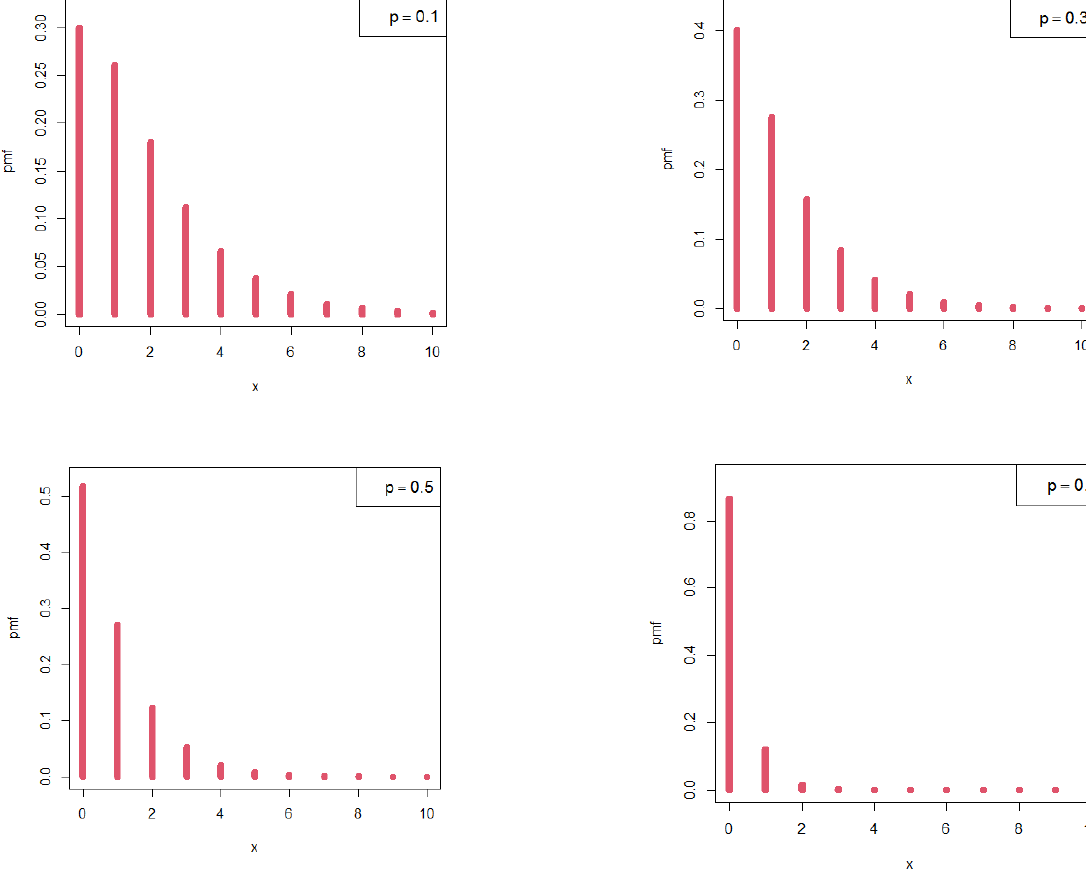
Figure 1. Pmf of BNDL distribution for some choices of p .